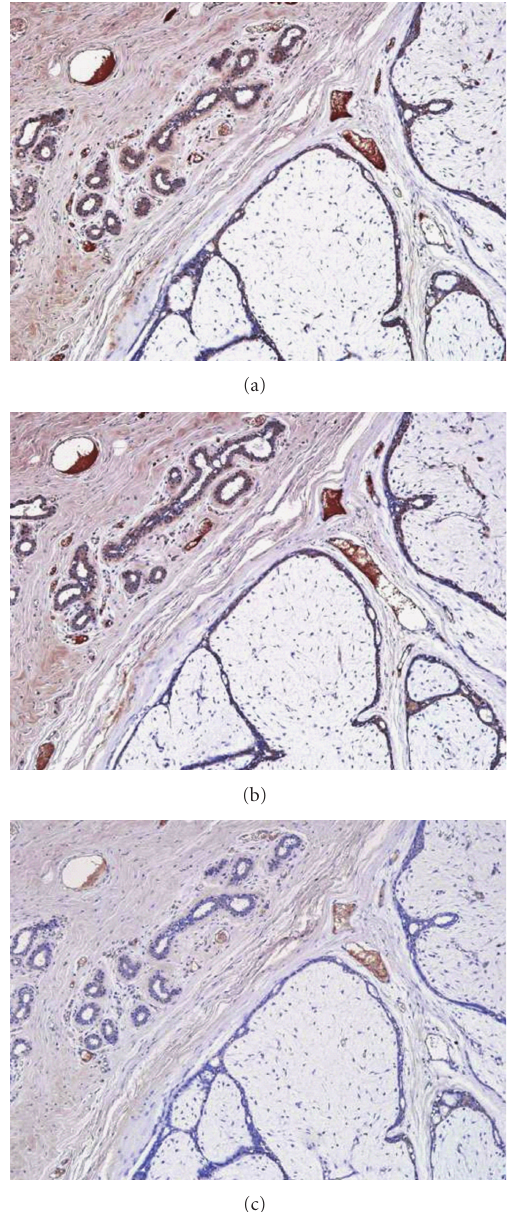
Figure 8: Antibody absorption test with insulin added to the primary serum at 40ng/mL (a), 4 µ g/mL (b), and 40 µ g/mL (c). Staining intensity attenuated corresponding to insulin concentra- tion. At 40 ng/mL, positive staining of ductal epithelia remained, while at 4 µ g/mL, staining intensity decreased significantly and almost disappeared at 40 µ